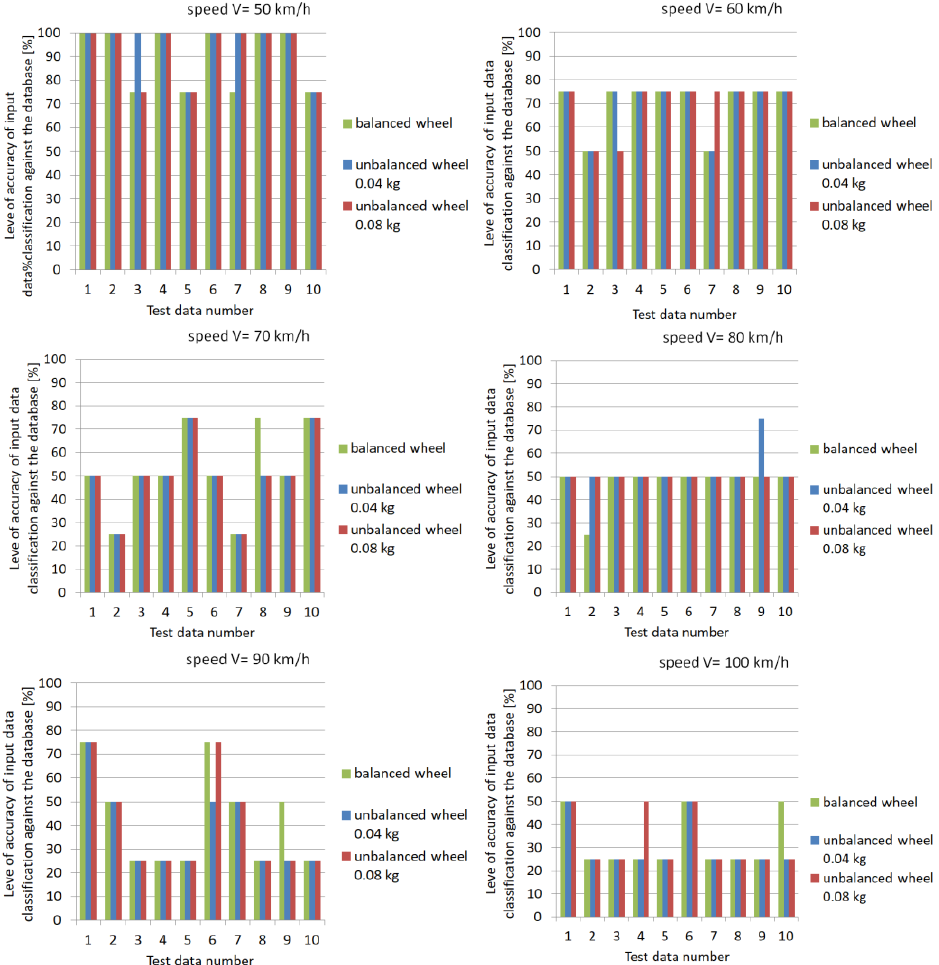
Figure 22. Level of accuracy of input data classification against the database.